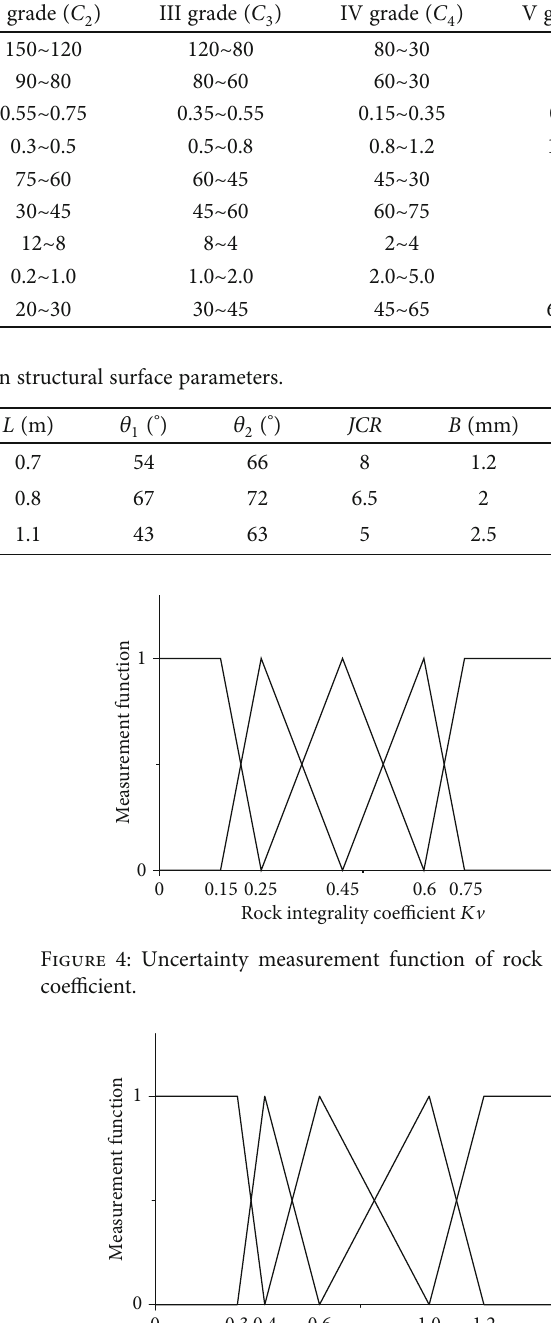
Figure 3: Uncertainty measurement function of RQD.